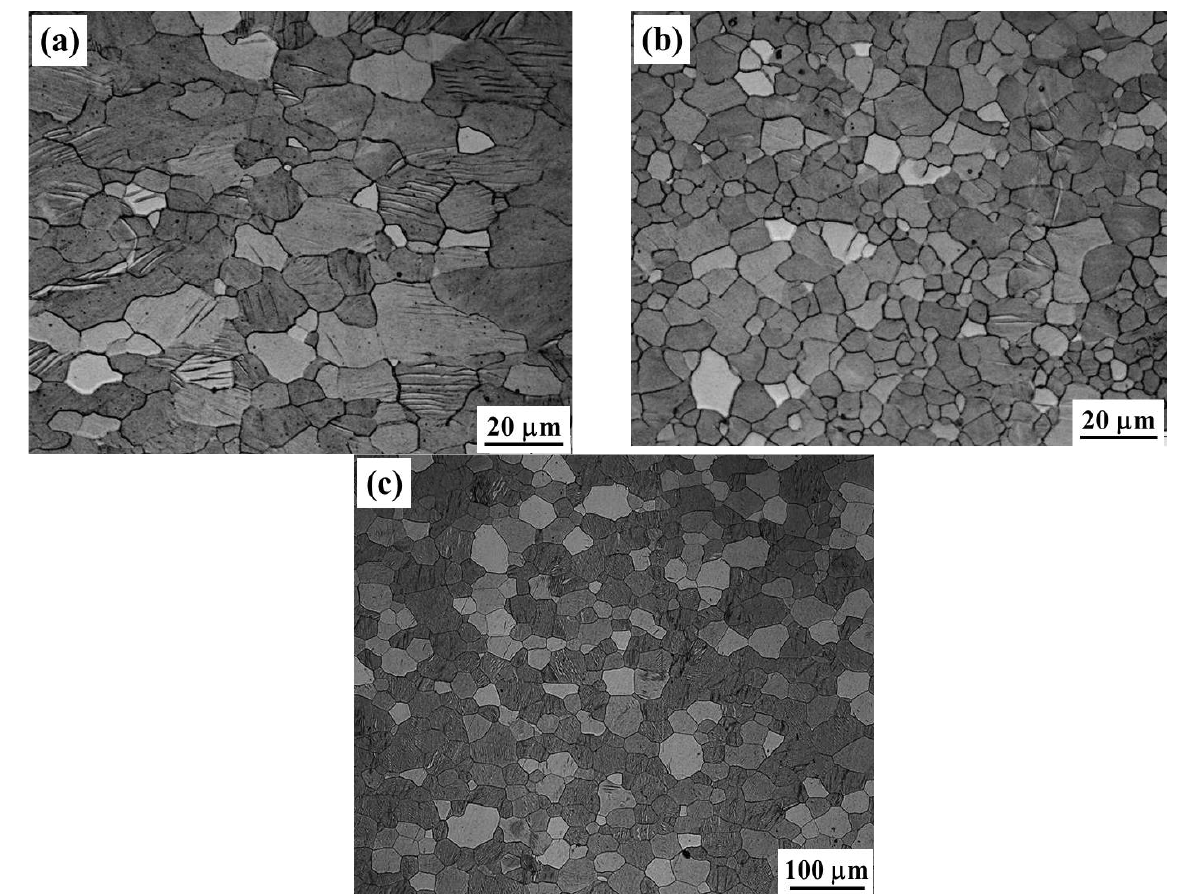
Figure 6. Microstructures of AZ31 alloy extruded at 300 o C and compressed